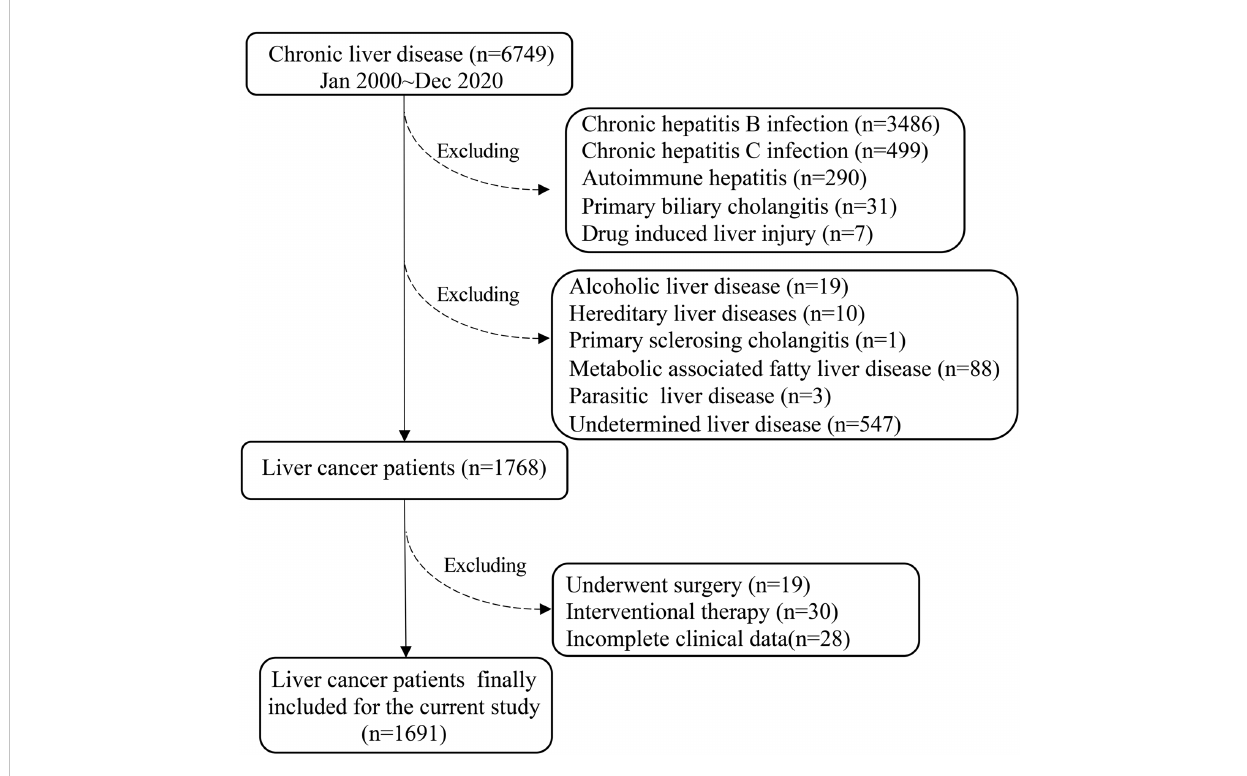
FIGURE 1 The fl ow chart demonstrated the selection criteria for PLC